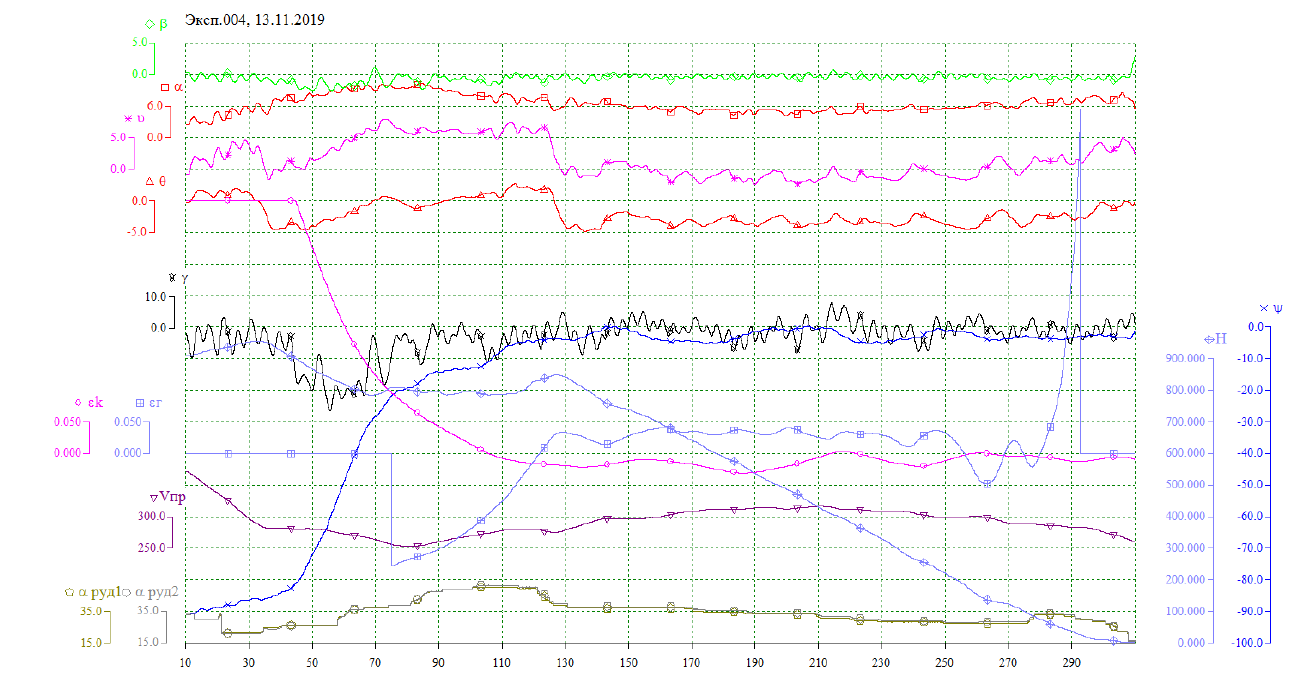
Fig. 1. IAS “Flight” with failures of the first and third fly-by-wire channels, and the control failure of the left aileron and interceptors on the port wing, where V is is instrument speed (km/h); ψ is a magnetic course (degrees): Θ is a flightpath angle (degrees); ϒ is a bank angle (degrees ); υ is a pitch angle (degrees); α is the angle of attack (degrees); β is a sideslip angle (degrees); H is geometric altitude (m); εc is a deviation from the course equisignal zone (DDM ); εg is a deviation from the glide path (DDM ); α is the engine control lever position